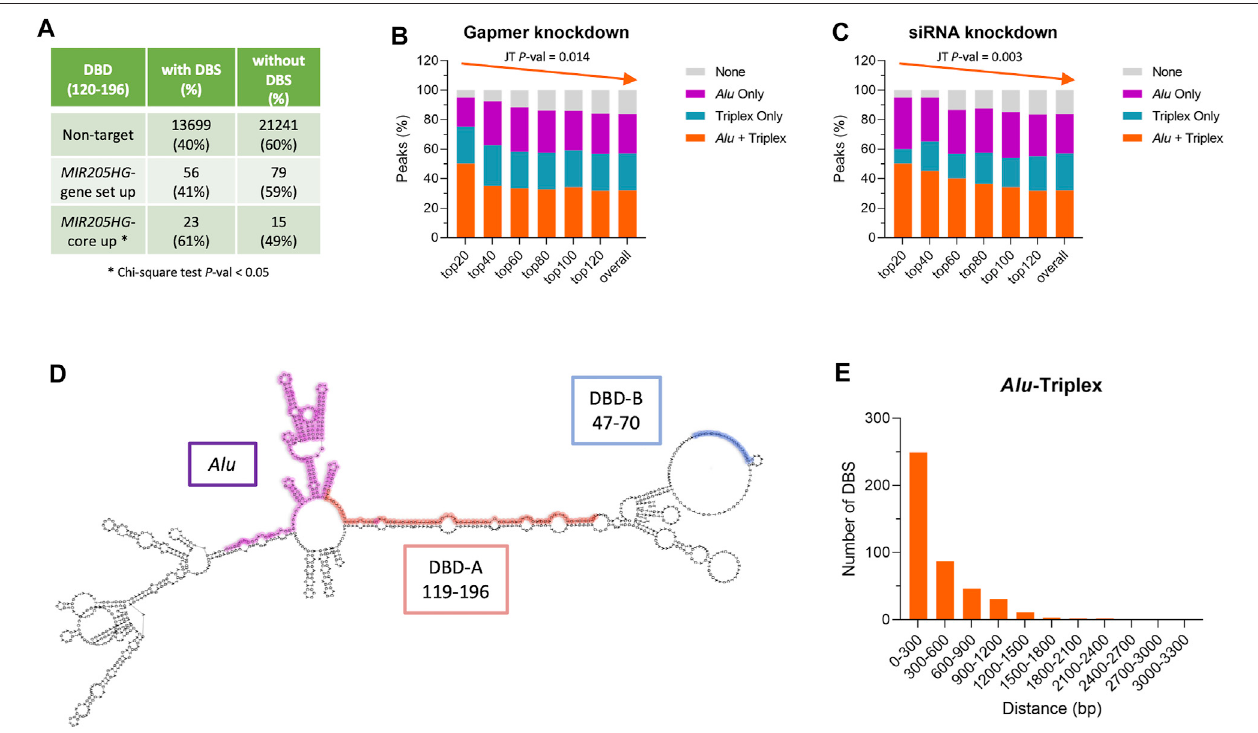
FIGURE 4 | The presence of Alu and triplex-forming regions is afeature ofboth MIR205HG and its targetgenes. (A) Table showing the number and percentage of genes predicted to form or not a triplex with MIR205HG in lists of non-target genes ( “ Non-target ” ), genes commonly up-modulated after MIR205HG knockdown using either a siRNA or a gapmer ( “ MIR205HG -gene set up ” ), and genes commonly upmodulated after MIR205HG knockdown and coherently downmodulated after MIR205HG overexpression ( “ MIR205HG -core up ” ). Gene lists are from Profumo et al. (2019). (B) Bar plot showing the percentage of genes having a DBS (i.e., a triplex) and/or Alu element among genes differentially expressed after MIR205HG knockdown using a gapmer antisense oligonucleotide. Signi fi cance of the monotone trend oftriplex + Alu percentage inregulated genesranked forfold-change(top20 geneshave thehighest fold-change) wasassessed byJonckheere-Terpstra(JT) test. (C) BarplotshowingthepercentageofgeneshavingaDBS(i.e.,atriplex)and/or Alu elementsamonggenesdifferentiallyexpressedafter MIR205HG knockdownusinga siRNA. Signi fi cance of the monotone trend of triplex + Alu percentage in regulated genes ranked for fold-change (top20 genes have the highest fold-change) was assessed by Jonckheere-Terpstra (JT) test. (D) MIR205HG predicted secondary structure (as from RNAfold); DBD-A, DBD-B and Alu elements are highlighted in the structure. (E) Distancebetweenthetriplex(DBS)andthe Alu elementin MIR205HG proximalregionpeaksformingatriplex.Barplotsandthetableweregeneratedusing GraphPad Prism and Microsoft Excel,